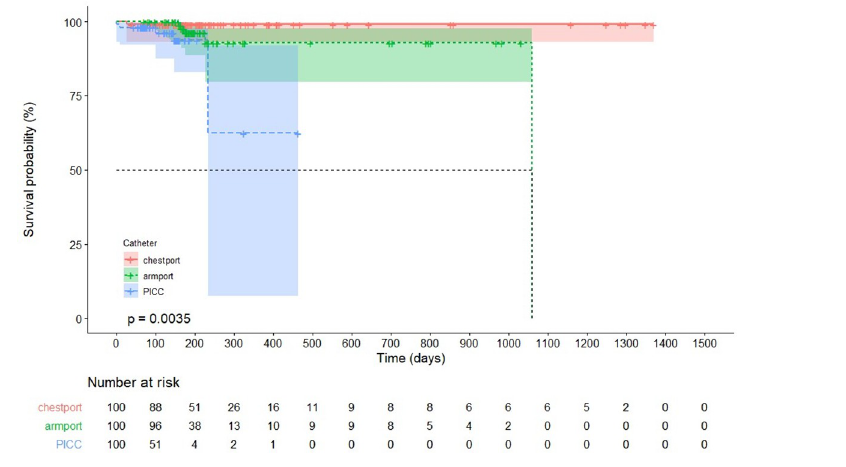
Fig 2. Cumulative incidence of complication-free catheter usage